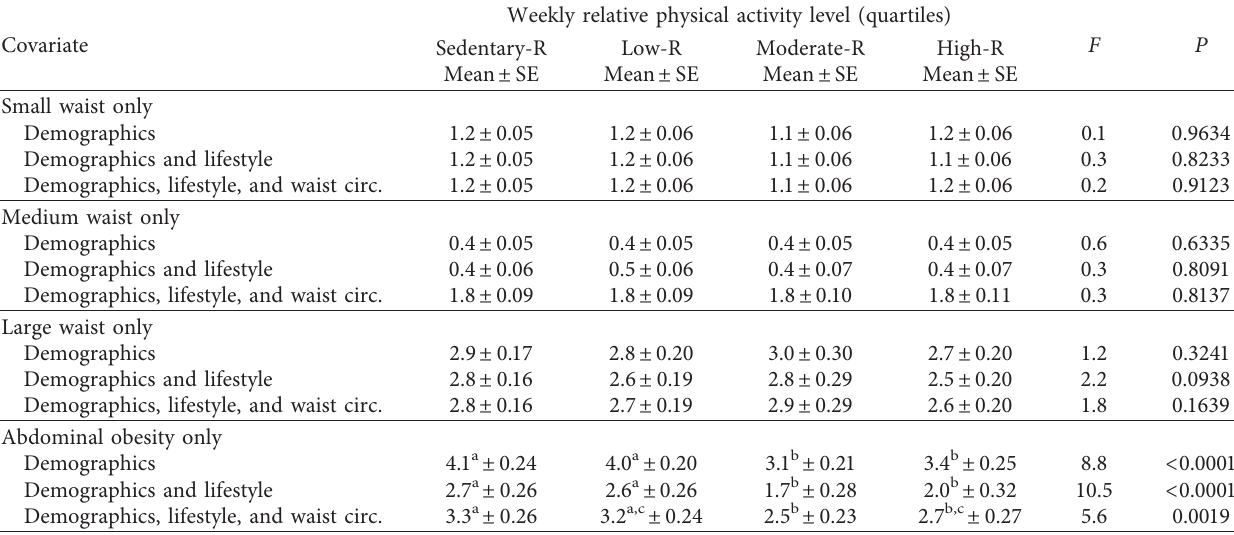
Weekly relative physical activity level (quartiles)